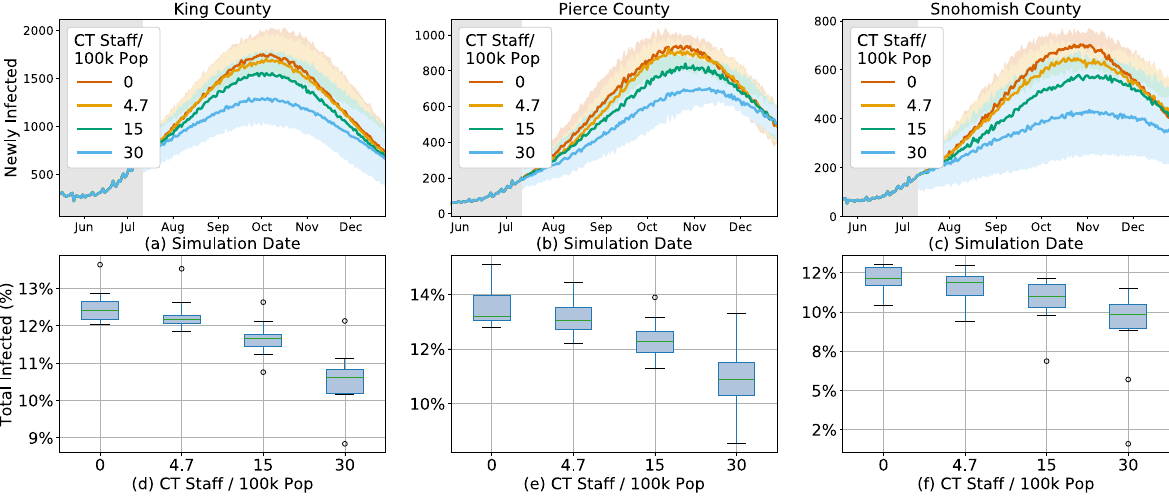
Fig. 4 Infections under manual contact tracing. Estimated effect of manual contact tracing on new infections ( a – c ) and total infected percentage ( d – f ) at various staf fi ng levels per 100k people in King ( a , d ), Pierce ( b , e ), and Snohomish ( c , f ) counties between July 11, 2020 and December 25, 2020.